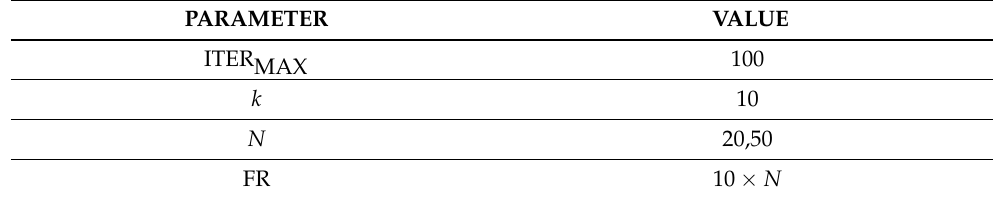
Table 1. Parameters for the experiments.